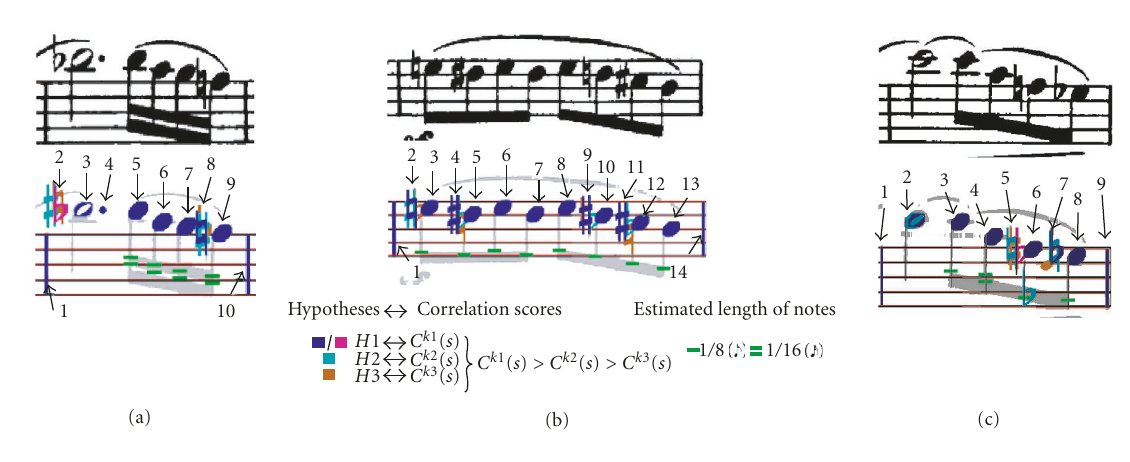
Figure 12: Original images and recognition